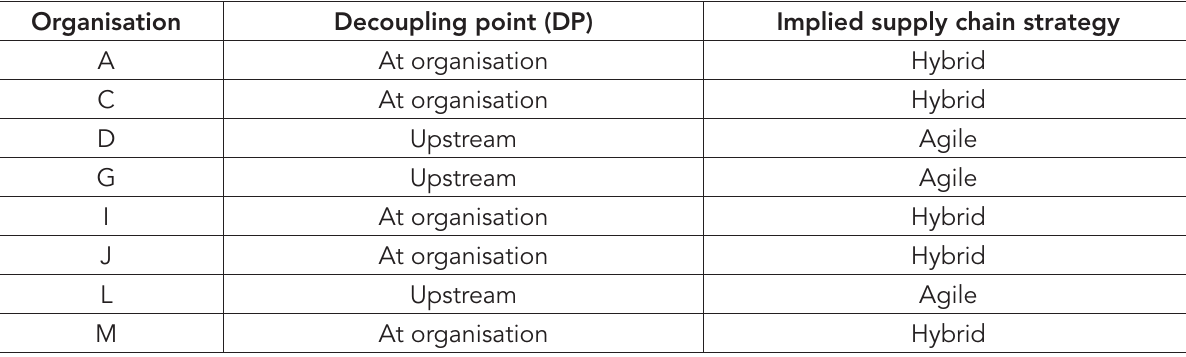
Table 3: Implied supply chain strategies based on decoupling points Organisation